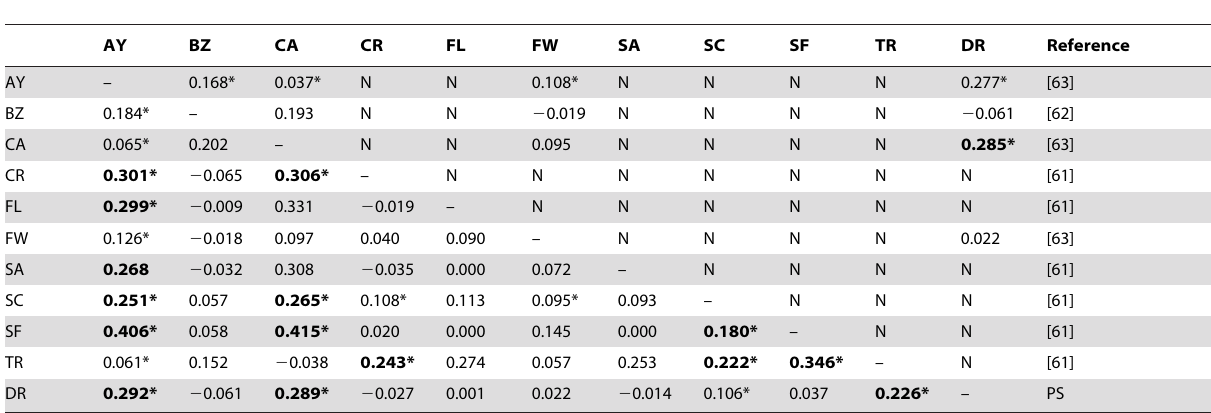
Table 2. Genetic distances ( W st ) between Atlantic/Indic leatherback nesting